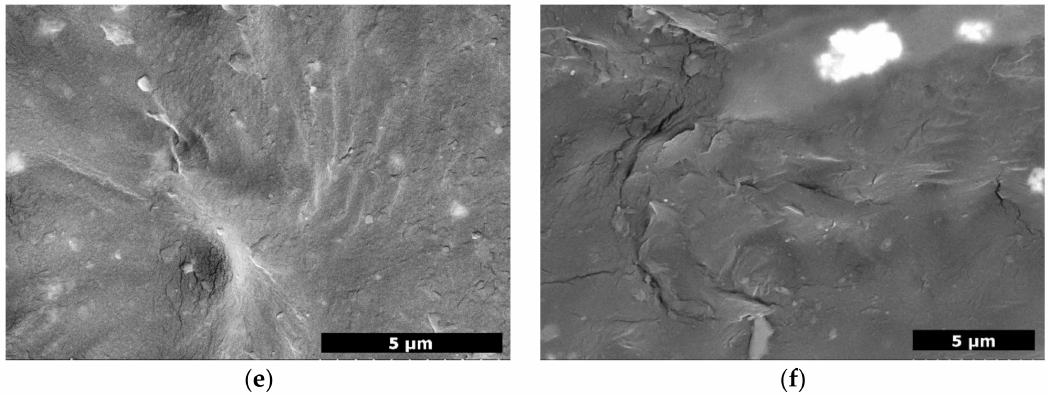
Figure 7. Backscattered SEM micrographs of ( a ) PCL/bBG 0.5%, ( b ) PCL/bBG 1.0%, ( c ) PCL/bBG 2.5%, ( d ) PCL/tBG 0.5%, ( e ) PCL/tBG 1.0%, ( f ) PCL/tBG